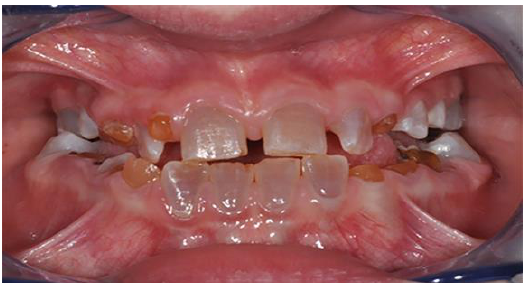
Figure 1. Imperfect dentinogenesis: the dental elements show a color ranging from opalescent grey to yellow.